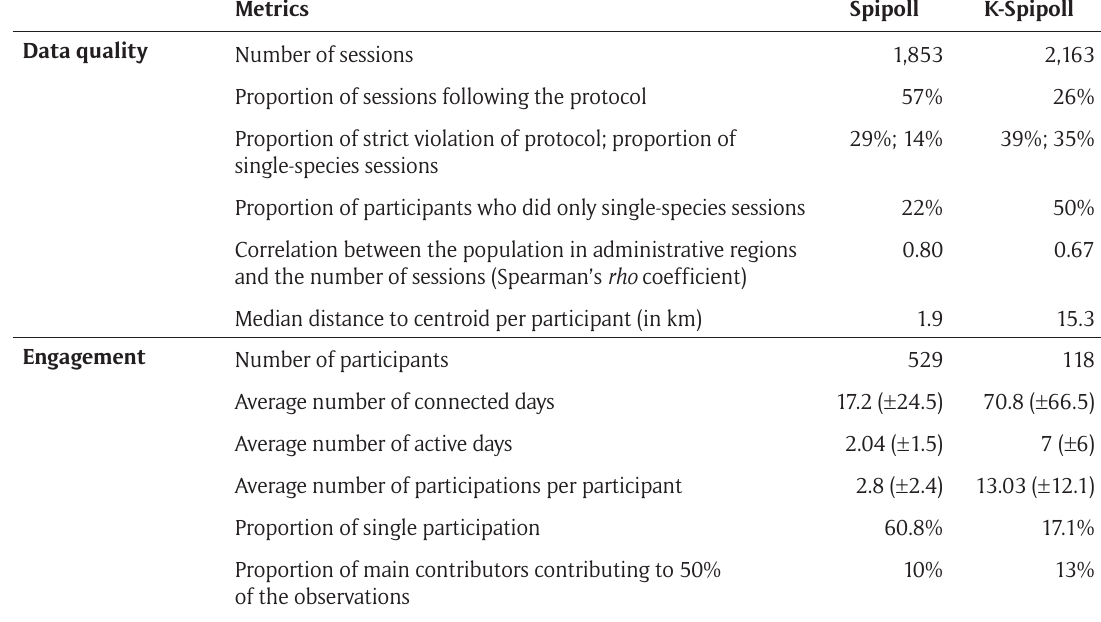
Table 2: Comparison of data quality and participant’s engagement between the K-Spipoll and the Spipoll